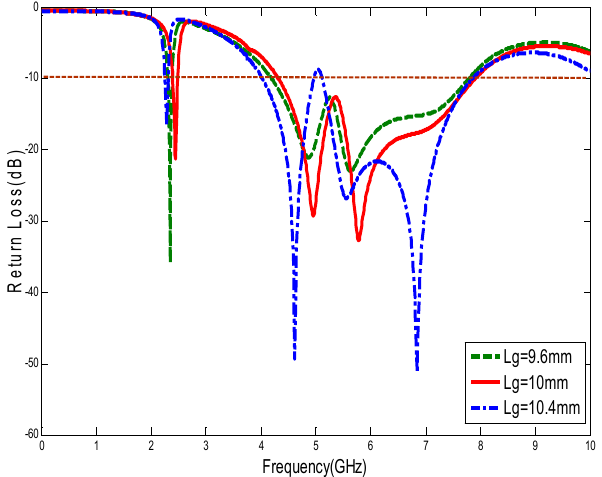
Figure 11. Simulated return loss versus frequency for the proposed antenna for various values of L 7 ; other parameters are the same as those listed in Table 2.